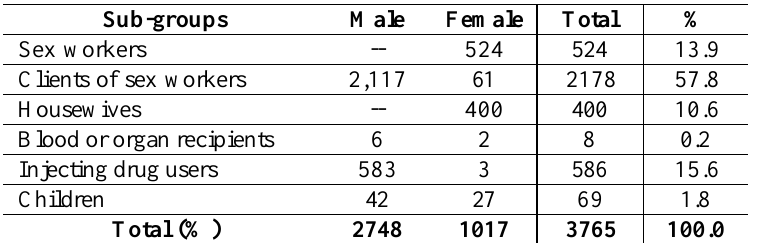
Table II : Cumulative HIV infection by sub-group and sex by May